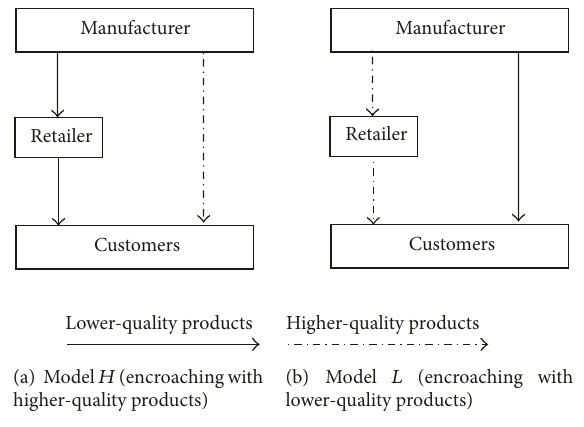
Figure 1: The two basic